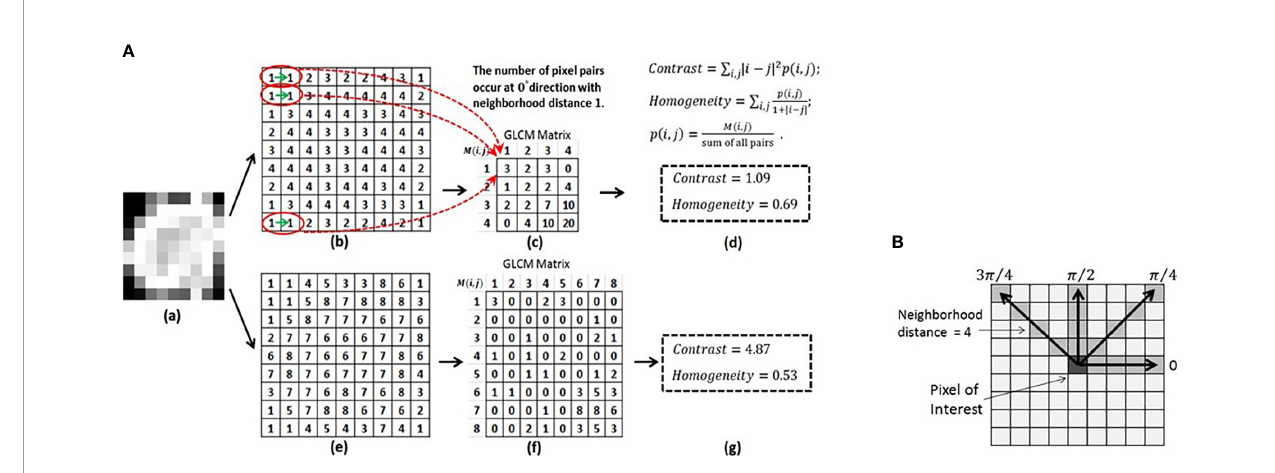
FIGURE 6 | (A) Computing the GLCM features of Contrast and Homogeneity using different bin levels. (a) Original image. (b) Normalized image using the bin level of 4. (c) GLCM matrix derived from (b). (d) Contrast and Homogeneity computed from GLCM in (c). (e) Normalized image using the bin level of 8. (f) GLCM matrix derived from (e). (g) Contrast and Homogeneity computed from GLCM in (f). (B) Calculation of the GLCM features for a 9X9 2D image at four directions and a neighborhood distance of 4 pixels. Reproduced with permission from